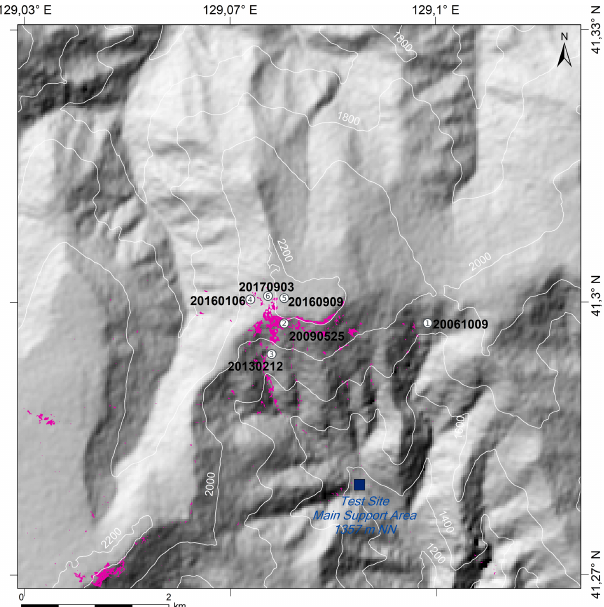
Figure 14. Change detection analysis via NDVI (Normalized Dif- ference Vegetation Index) from Pleiades data showing potential landslides (in purple patches) triggered by the 2017 nuclear test. Numbered circles indicate the epicenters of the tests from 2006 to